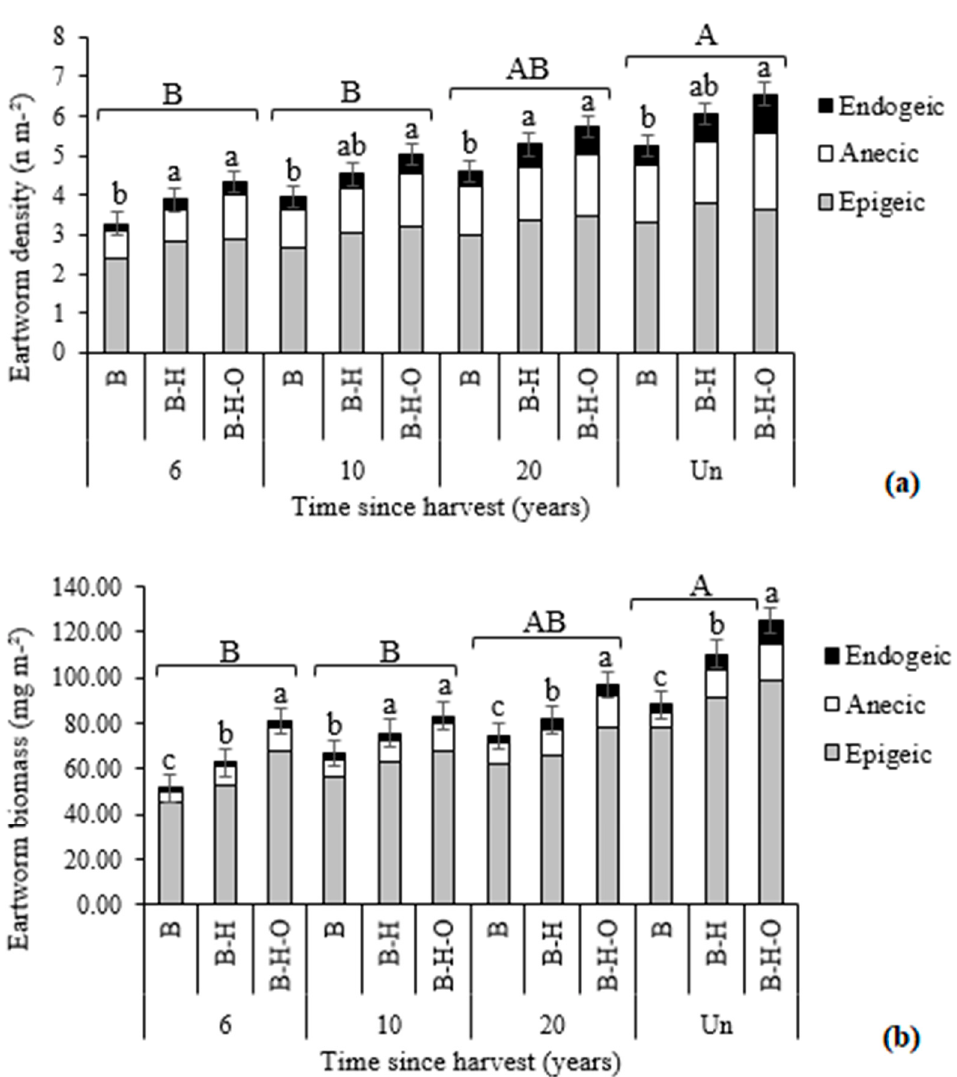
Figure 2. Mean values of earthworm density (epigeic, anecic, and endogeic) ( a ) and biomass ( b ) in different years since harvest and in undisturbed area, under three litter treatments. The litter treatments studied were beech (B), beech–hornbeam (B-H), and mixed beech (B-H-O). Harvesting period: 6, 10, and 20 years since harvest. For earthworm density, time since harvest (F = 69.441; p < 0.001), litter treatment (F = 52.393; p < 0.001), and their interaction (F = 3.216; p = 0.035). For earthworm biomass, time since harvest (F = 20.742; p < 0.001), litter treatment (F = 47.574; p < 0.001), and their interaction (F = 10.560; p < 0.001). Different capital and lowercase letters indicate significant differences ( p < 0.05 by Duncan test) between the harvesting period (year since harvest) and the litter treatments,